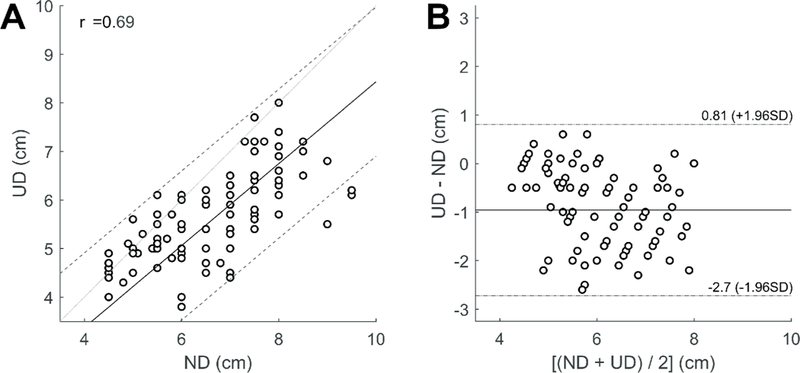
(A) Correlation plot of ultrasound depth versus needle depth at which CSF was visualized, Pearson correlation coefficient r=0.69 (95% CI:0.45–0.84, p<0.001). The thick line is the correlation and the dashed lines are the 95% confidence intervals. (B) Bland-Altman analysis of ultrasound depth vs. needle depth.